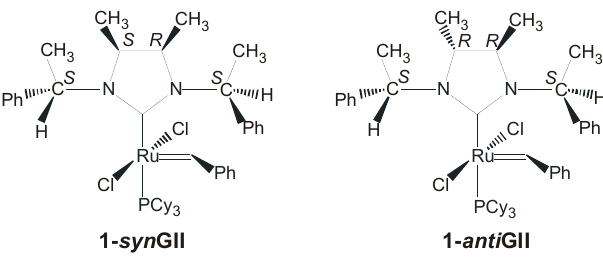
Figure 2. NHC-Ru complexes with N -( S )-phenylethyl groups and syn or anti methyl groups on the backbone.